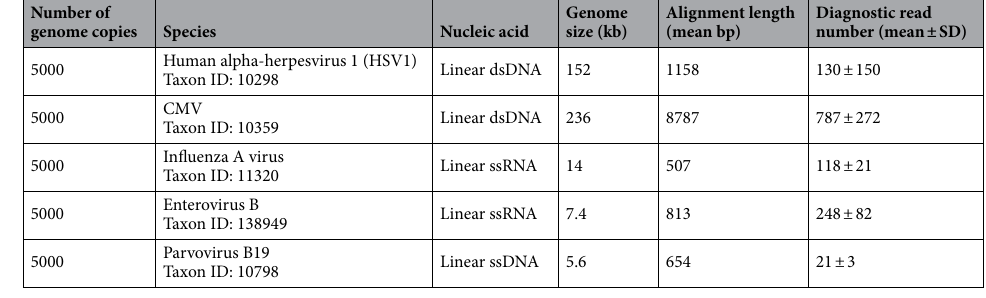
Table 1. Diagnostic viral read numbers after spiking 5000 genome copies of 5 different cultured viruses into 200 μl human amniotic fluid. ds double stranded, ss single stranded.